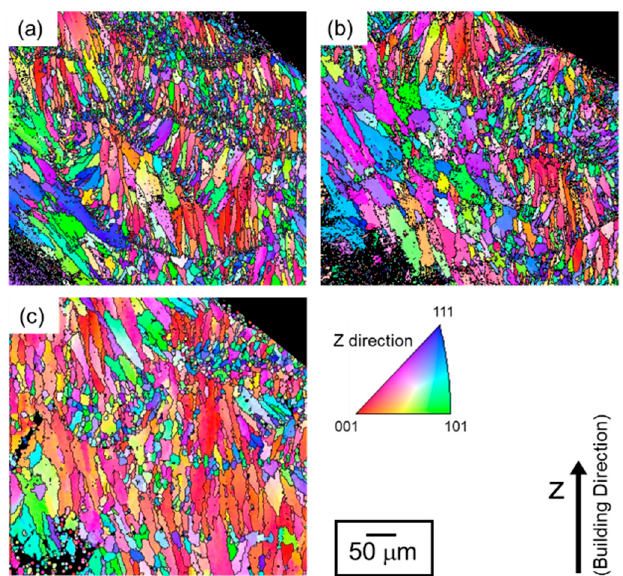
Figure 13. Orientation distribution maps of strut portion of the lattice specimen: ( a ) as-manufactured, ( b ) annealed at 300 ◦ C for 2 h, and ( c ) solution heat treated at 530 ◦ C for 6 h.